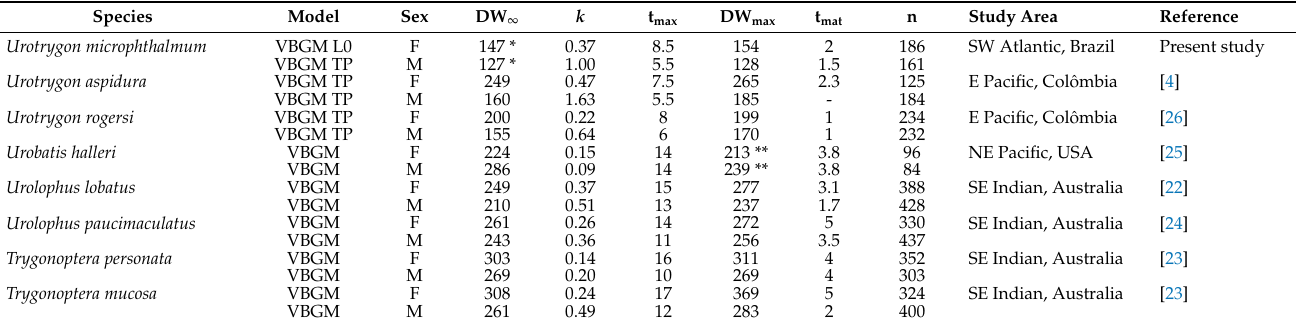
Table 3. Growth parameters of related species of the families Urolophidae and Urotrygonidae. DW ∞ , asymptotic disc width (in mm); k , annual growth rate; t max , the maximum age (in years); DW max , maximum disc width (in mm); t mat , age at maturity (in years). * TL ∞ converted to DW ∞ ; ** DW of the oldest specimens